Question: How would you classify this visualization?
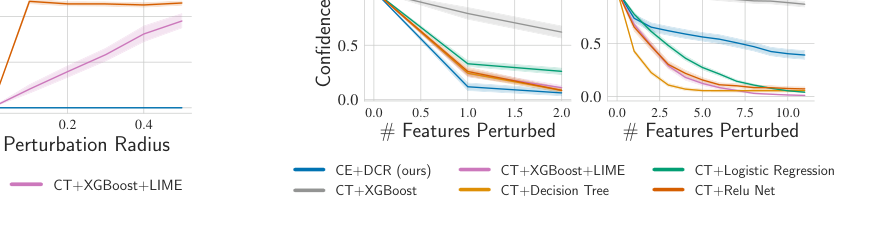
Answer: line